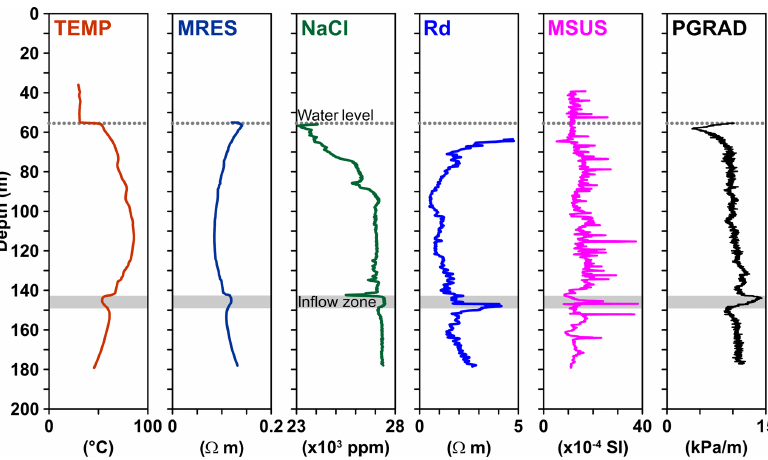
Figure 7. Selected results of geophysical downhole logging, borehole SE-02b, showing temperature (TEMP), fluid resistivity (MRES), fluid salinity as derived from resistivity measurements (NaCl), rock resistivity (Rd), magnetic susceptibility (MSUS), and the fluid pressure vertical gradient (PGRAD) as derived from the measured fluid pressure (not shown) (following Weisenberger et al., 2019).